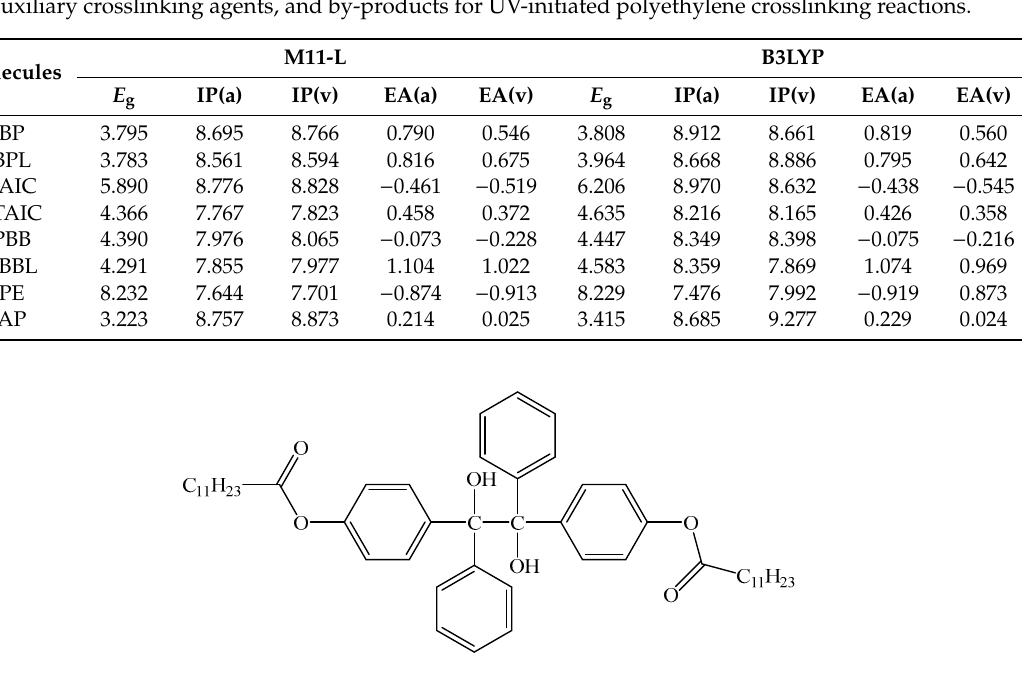
Figure 3. The molecular schematics of by-product PBBL produced by BPL in a UV-initiated crosslinking reaction of polyethylene.